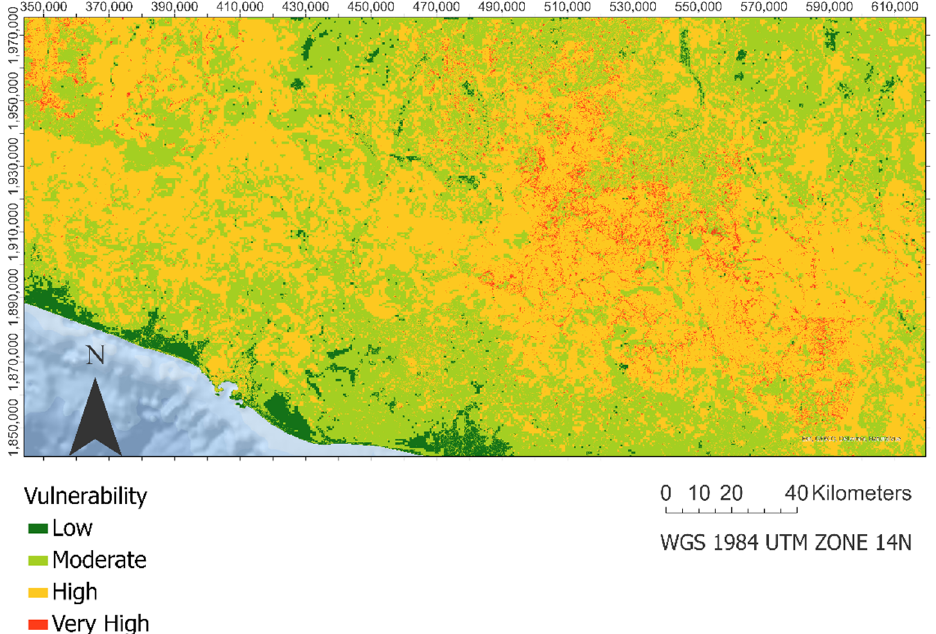
Figure 5. Landslide vulnerability integration. This includes the estimation of ecological vulnerability and socio-economic vulnerability.